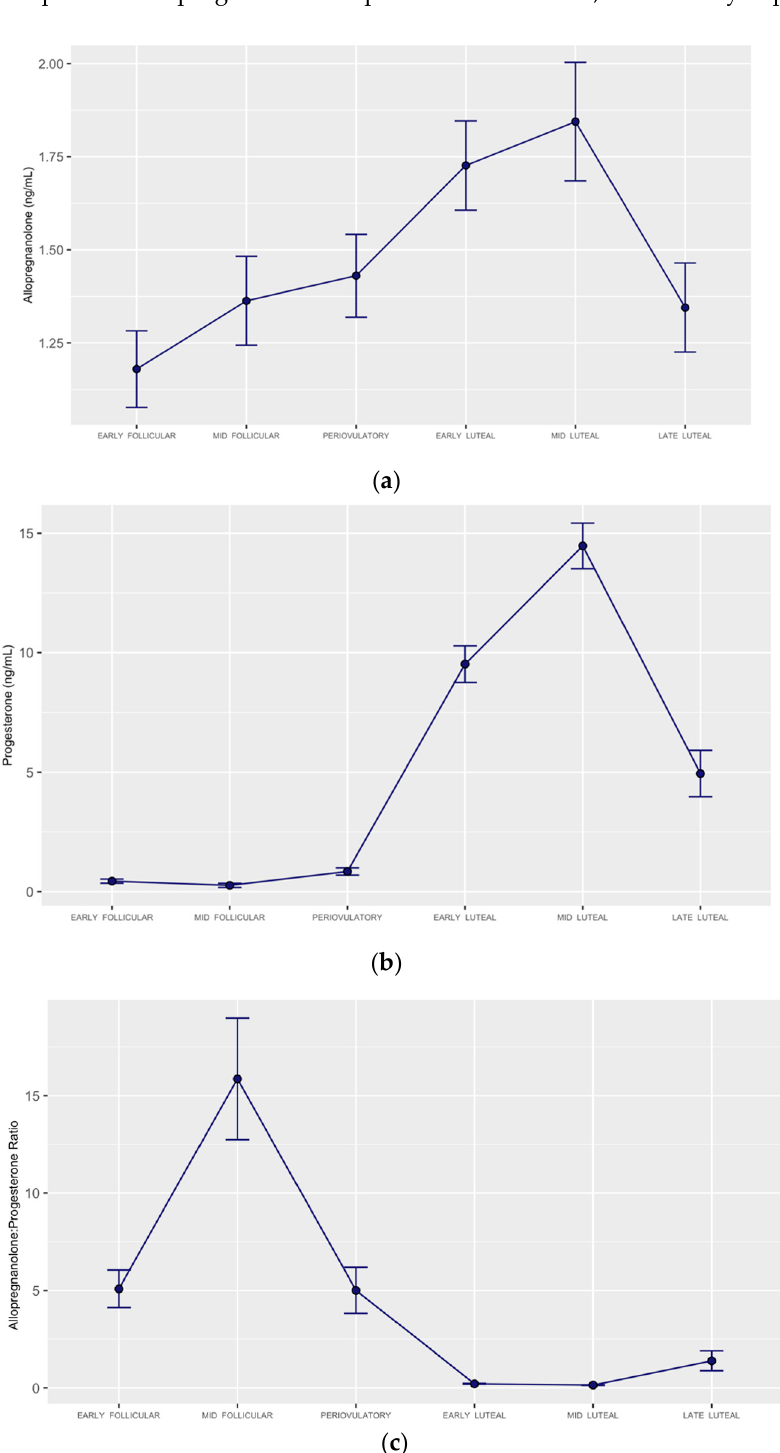
Figure 2. Allopregnanolone ( a ), progesterone ( b ), and allopregnanolone:progesterone ratio ( c ) mean and variance (SEM; presented as error bars) at each of the six subphases of the menstrual cycle.